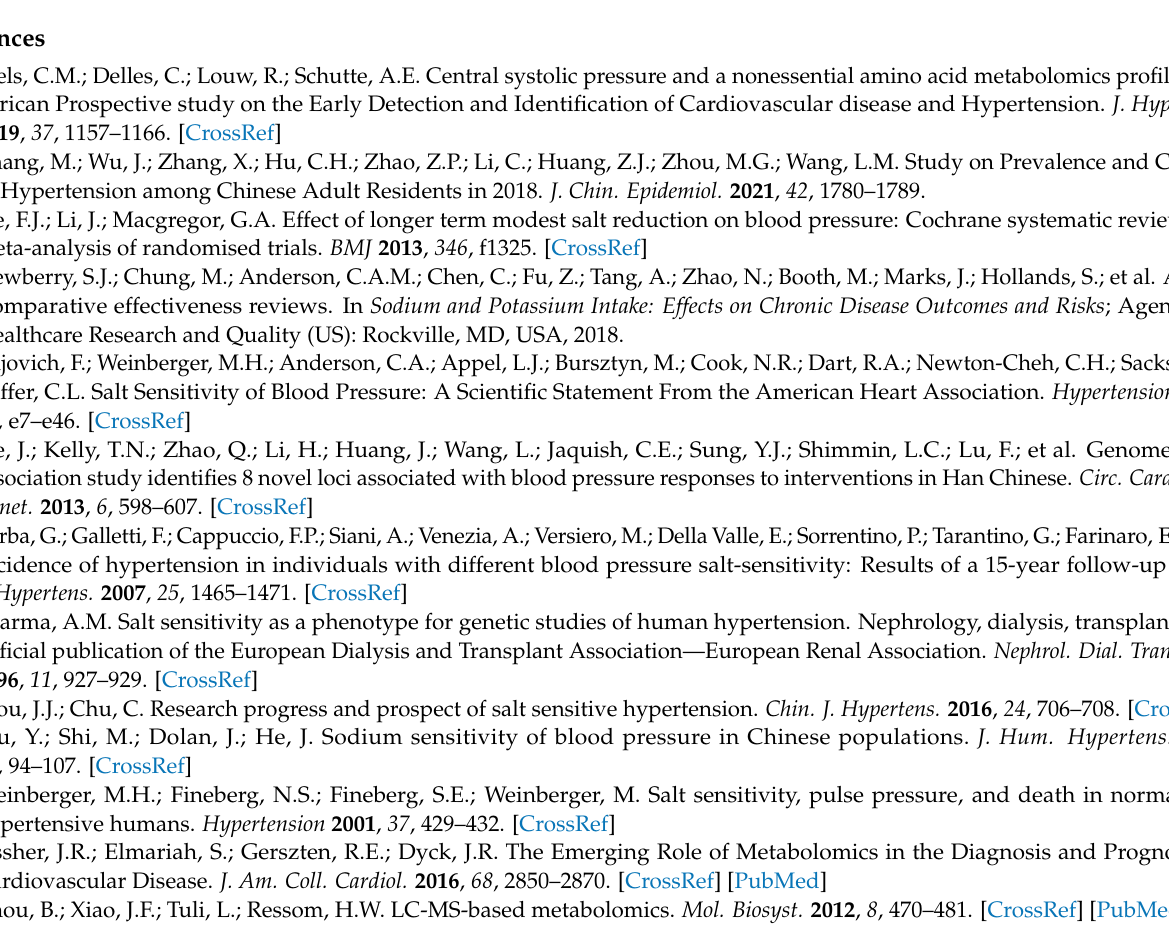
Table S3: Results of metabolites related logistic regression models for SS; Table S4: ROC analysis of